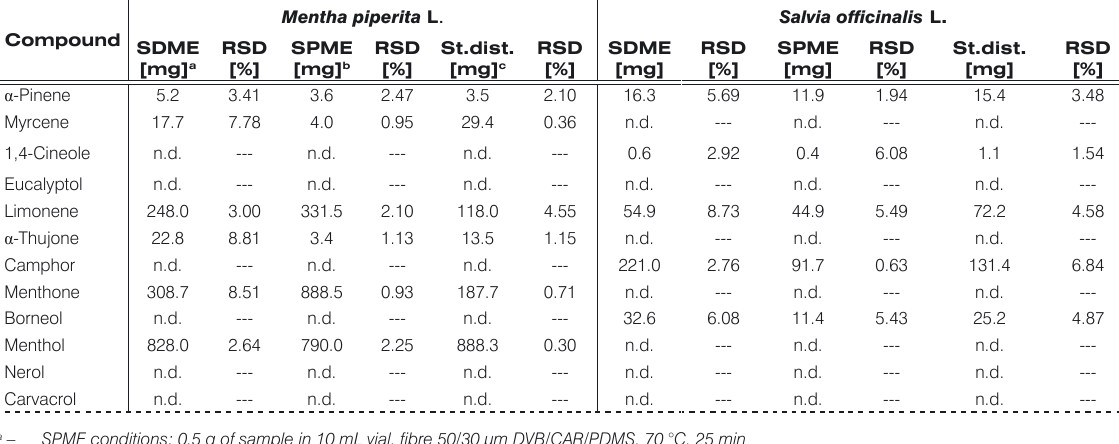
Table 3. Essential oils contents (per 100 g of dried leaves) of Mentha piperita L. and Salvia officinalis L. obtained by various methods